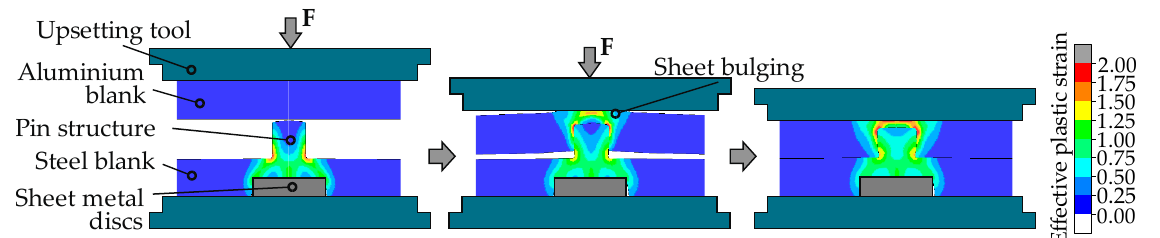
Figure 3. Illustration of the direct pin pressing joining strategy.